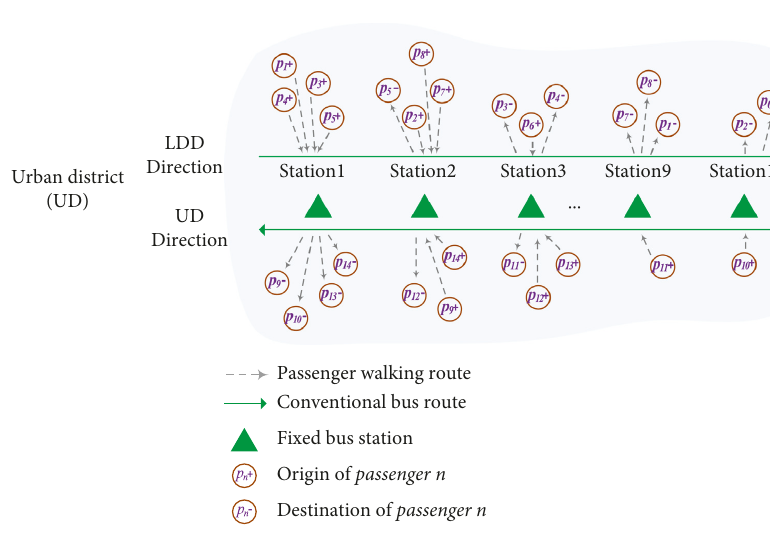
Figure 1: The conventional operation